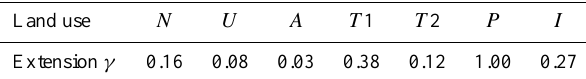
Table 2. Coefficient of extension γ